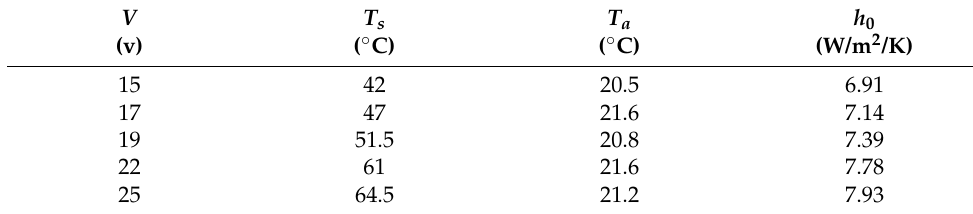
Table 3. Analytical analysis results including the radiation phenomenon.